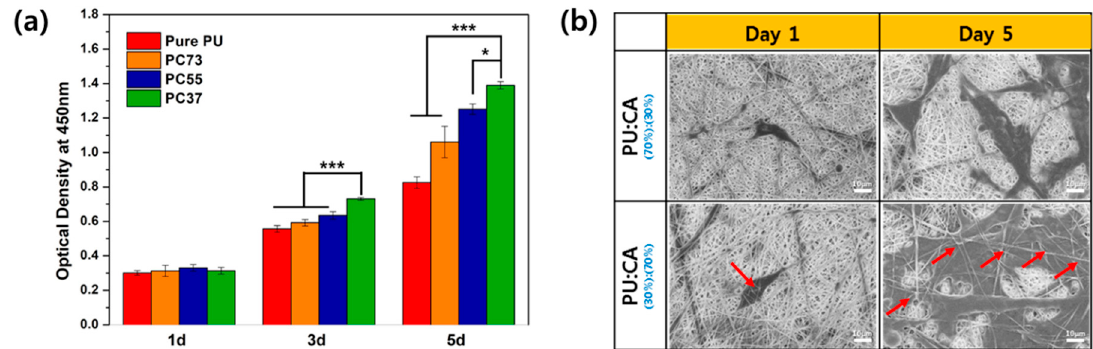
Figure 5. ( a ) CCK-8 assay result of NIH 3T3 fibroblast cell on different membranes and ( b ) SEM image of cell morphology. Data are expressed as mean ± standard deviation (SD), n = 3. (* p < 0.05, *** p < 0.001 indicates statistically significant difference with PC37).